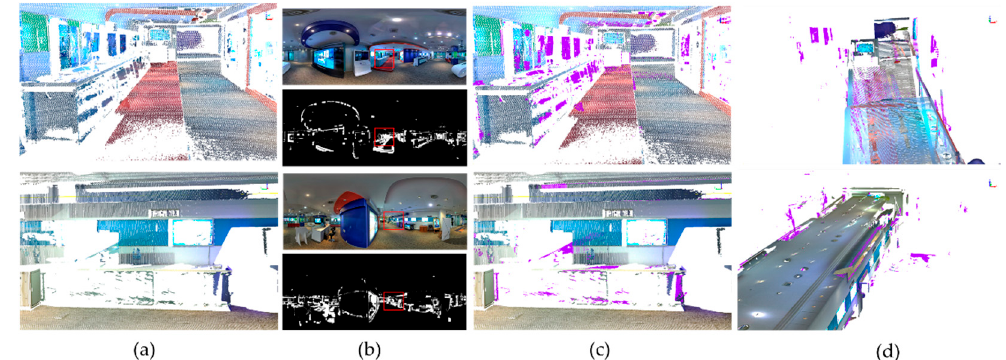
Figure 13. Noise detection results obtained using our method on single sensor data. ( a ) is the original point cloud image; ( b ) is the RGB image and the 2-D result map obtained by using our method; ( c ) is the obtained reflection noise region, the purple part of the figure; and ( d ) is the reflection noise region in another view.